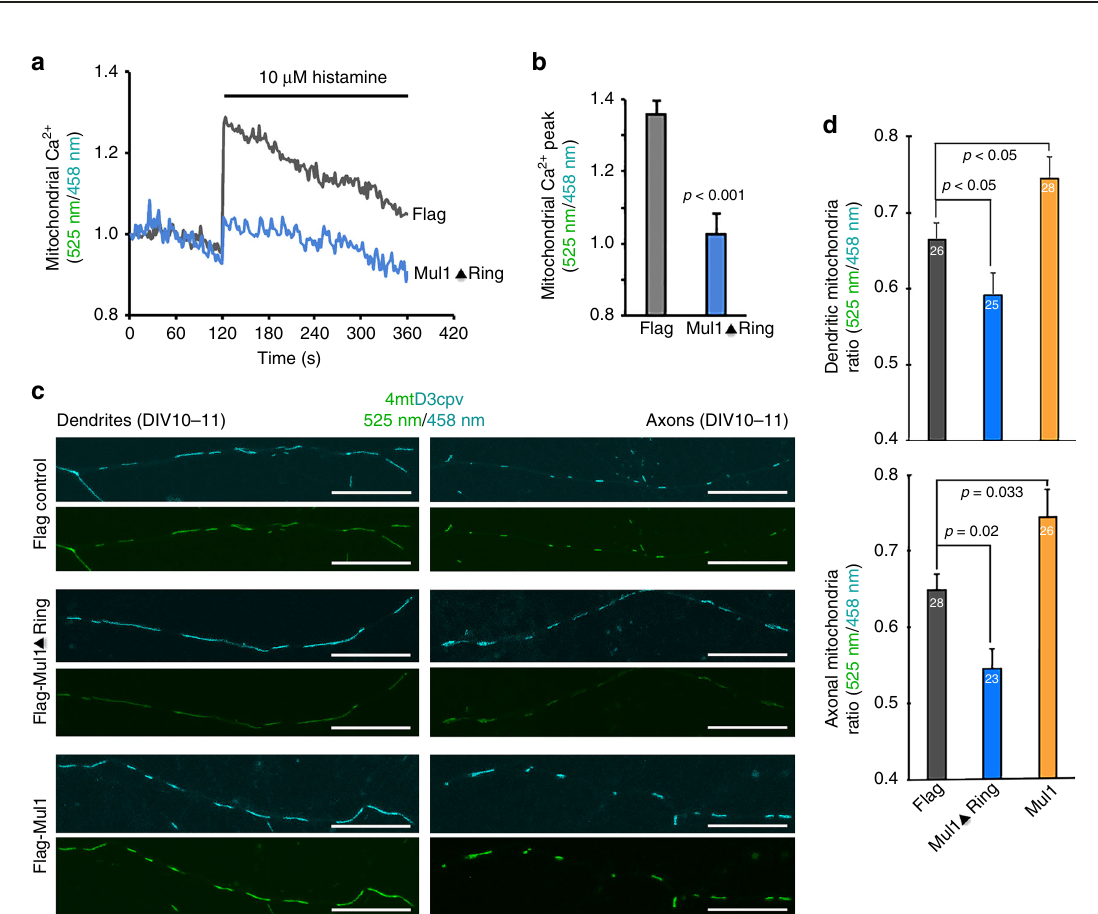
Fig. 5 Mul1 de fi ciency reduces ER-Mito contacts. a , b Representative STED images and quantitative analysis showing reduced ER-Mito contacts in dendrites of Mul1-de fi cient neurons. Cortical neurons were co-transfected at DIV7 with the ER marker GFP-Sec61 β and Flag, Flag-Mul1 Δ Ring, or Flag-Mul1. Neurons were fi xed at DIV11 and immunostained for Tom20. Super-resolution images were captured using dual-color 3D-STED nanoscopy. The relative colocalization between the ER and mitochondria was measured in both somato-dendritic and distal dendritic regions with a plug-in from Volocity Software and expressed as Mander ’ s colocalization coef fi cient. The yellow color represents overlap between the ER and mitochondria. Note that expressing Mul1 Δ Ring signi fi cantly reduces ER-Mito contacts while expressing Mul1 enhances the contacts relative to Flag baseline control. c – g Representative iTEM graphs and quantitative analysis showing reduced ER-Mito contacts in Mul1-de fi cient neurons. Neurons at DIV7-8 were co-transfected with GFP-Sec61 β and Flag, Flag-Mul1, Flag-Mul1 Δ Ring, Myc, Mfn1-Myc or Mfn2-Myc, followed by immunostaining with an anti-GFP antibody ( c , d ); or co-transfected with mcherry-Sec61 β b and scr-shRNA or Mul1-shRNA followed by immunostaining with an anti-mCherry antibody ( f ) and stained with a 10-nm gold-labeled secondary antibody at DIV10-11. A representative iTEM image shows speci fi c gold-labeling of ER membranes with an antibody against GFP ( c ) or mCherry ( f ). The ER tubular structures were colored with light blue while mitochondria were colored with light pink. The percentage of mitochondrial surface area contacting with ER were quanti fi ed by measuring the distance within a range of <12 nm between ER and mitochondrial outer membrane. Note that expressing Flag-Mul1 Δ Ring, Myc-Mfn2, or Mul1-shRNA signi fi cantly reduces ER-Mito contacts relative to control. All data were analyzed from the total number of neurons ( b ) or mitochondria ( e , f ) shown in the bars in three experiments and expressed as mean ± s.e.m. Ordinary one-way ANOVA with Dunnett ’ s post hoc test ( b , e ) and Mann – Whitney U -test ( g ). Scale Bars: 1 μ m ( a ) or 100 nm ( c , d , f )